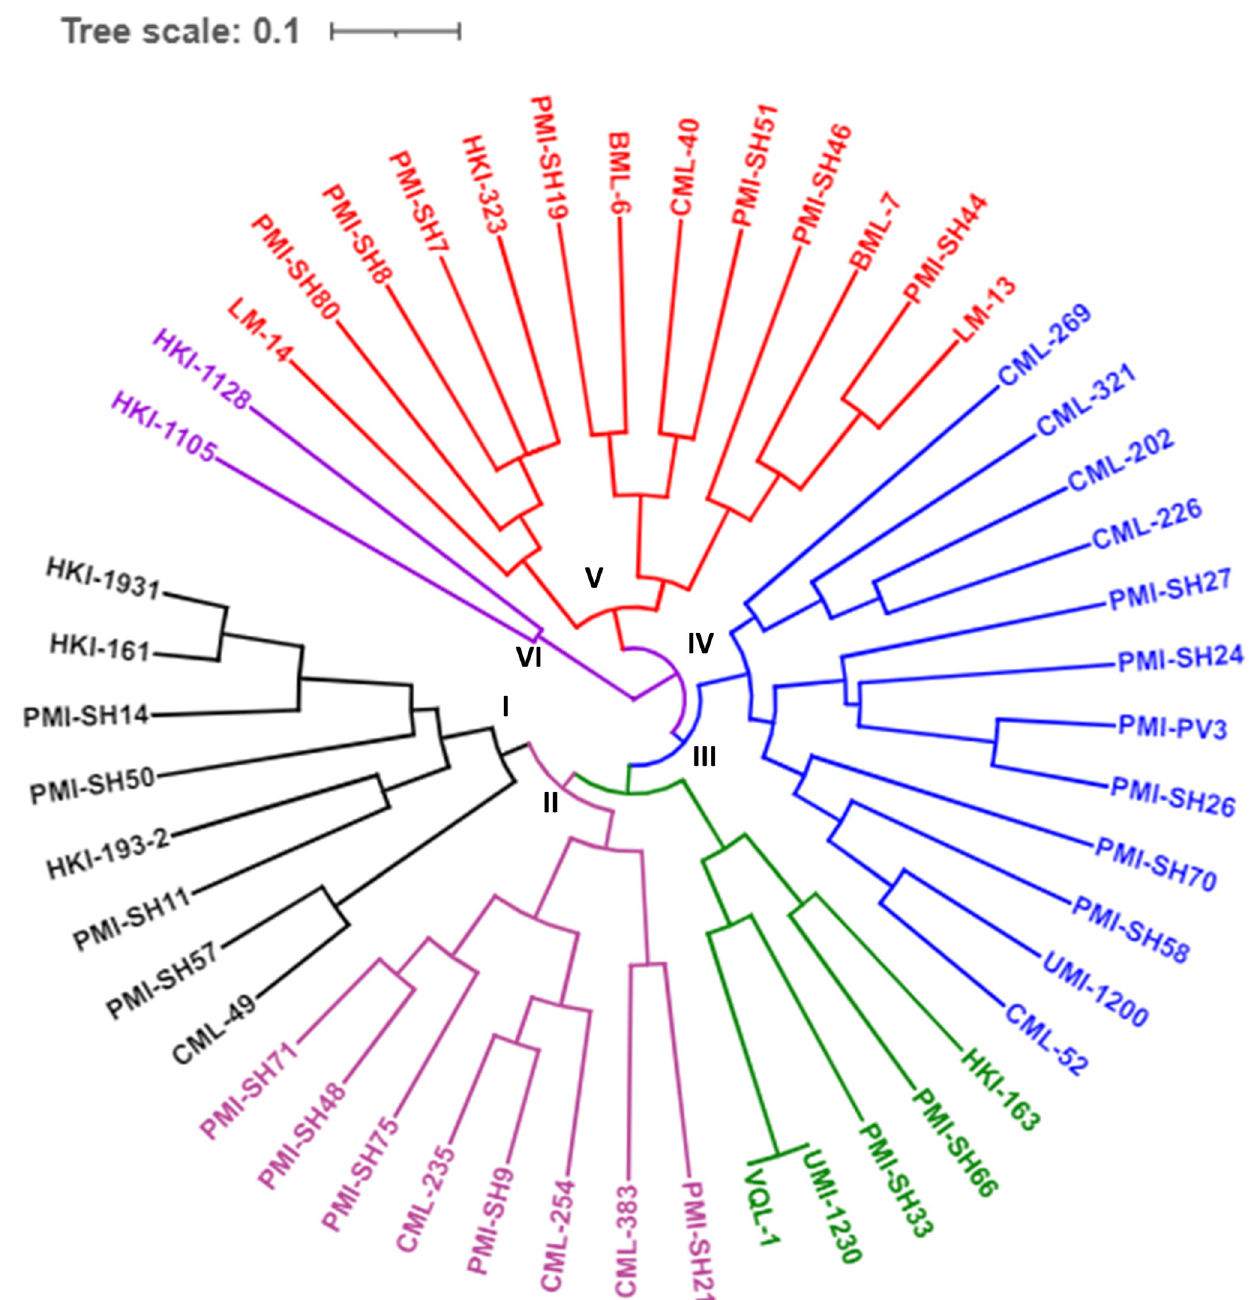
Fig 3. Dendrogram representing sh2 -gene based diversity using InDel